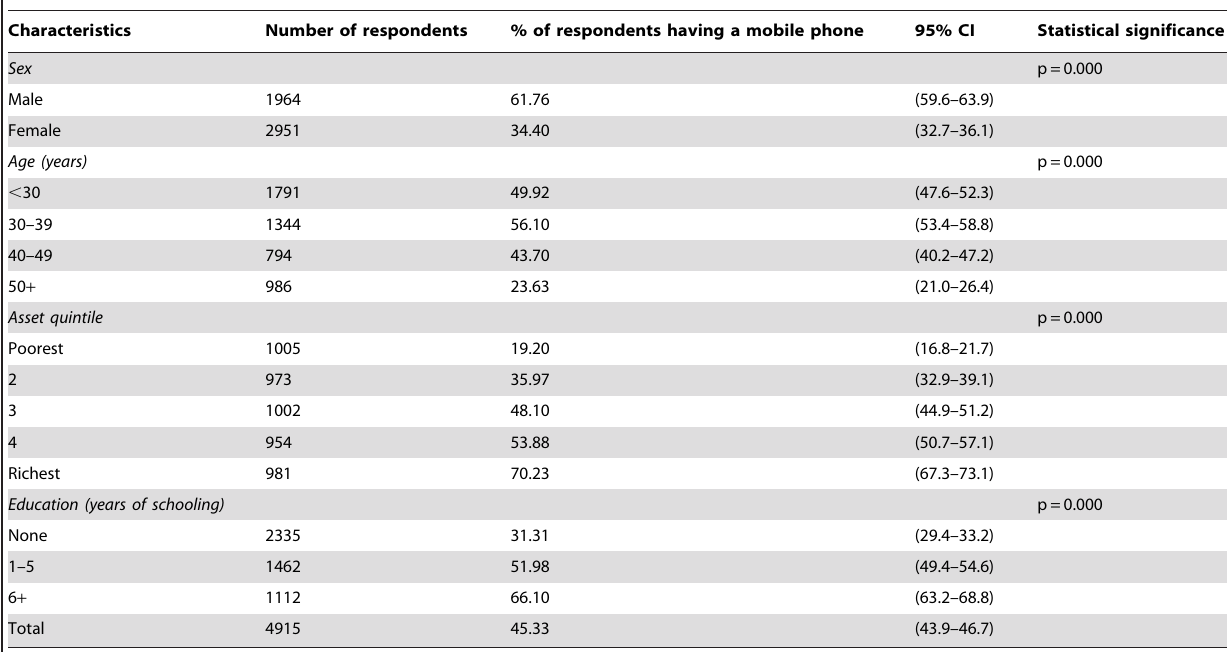
Table 2. Ownership of mobile phone by background characteristics.